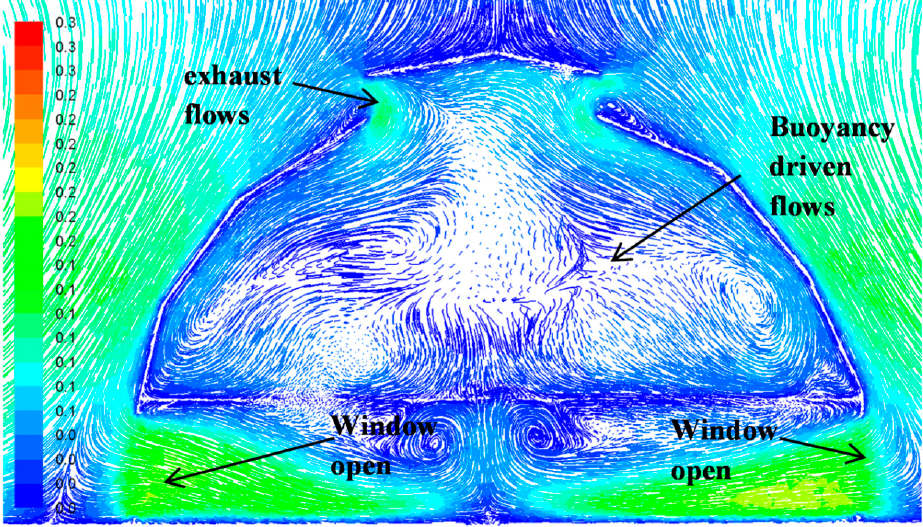
Figure 15. Streamline plot of velocity inside the dome during winter with very low or no wind speed.